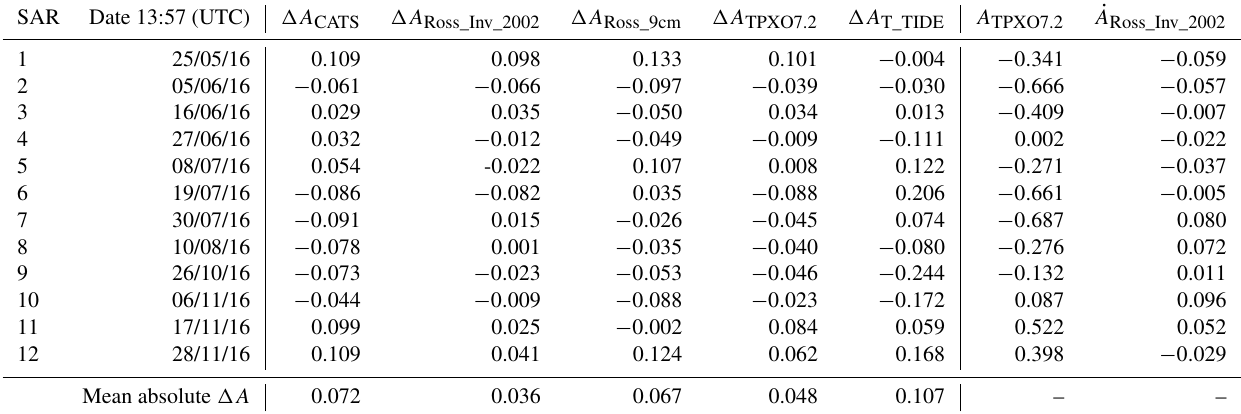
Figure 1. α maps of percentage vertical displacement due to ocean tides. Red colours highlight areas that can be assumed to be freely floating. The white crosses show the tide-model locations that also serve as a common reference point across the images. The solid black line is the location of the profiles shown in Figs. 2 and 3 on the southern McMurdo Ice Shelf (a) . The dashed black line shows the location of the profiles along the Darwin Glacier’s centerline shown in Fig. 6 (b) . The GPS station “Shirase” and “Hillary” in the tidal-flexure zone. White contours delineate areas of constant vertical displacement. The map background is contrast-stretched Landsat 8 panchromatic imagery. The geographic projection is Antarctic Polar Stereographic, with easting and northing coordinates shown in kilometres. Table 1. SAR imagery used for the Darwin Glacier, least-squares adjustment ( (cid:49)A in m) for five tide models, tidal amplitude ( A in m) as predicted with the TPXO7.2 tide model and rate of tidal change ( ˙ A in mh − 1 ) as predicted with the Ross_Inv_2002 tide model. SAR Date 13:57